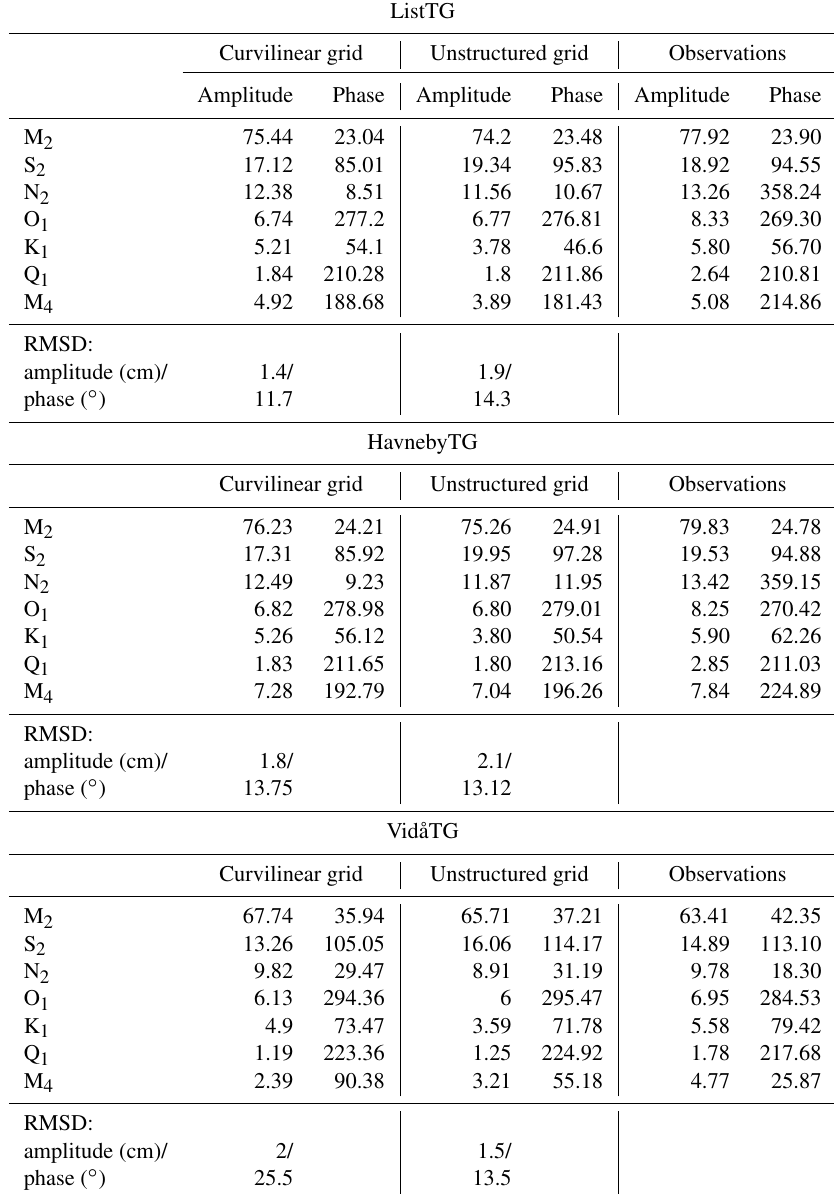
Table 3. Simulated and observed amplitudes (cm) and phases ( ◦ ) of the major tidal constituents at different locations.